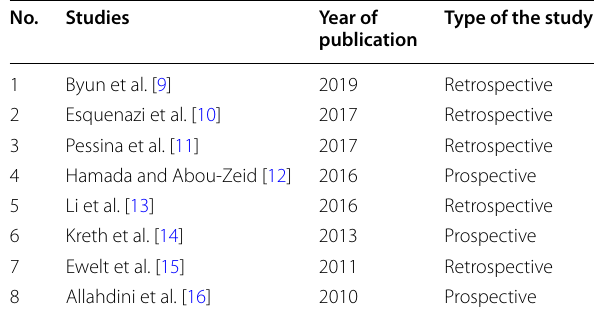
Table 1 Types of the included